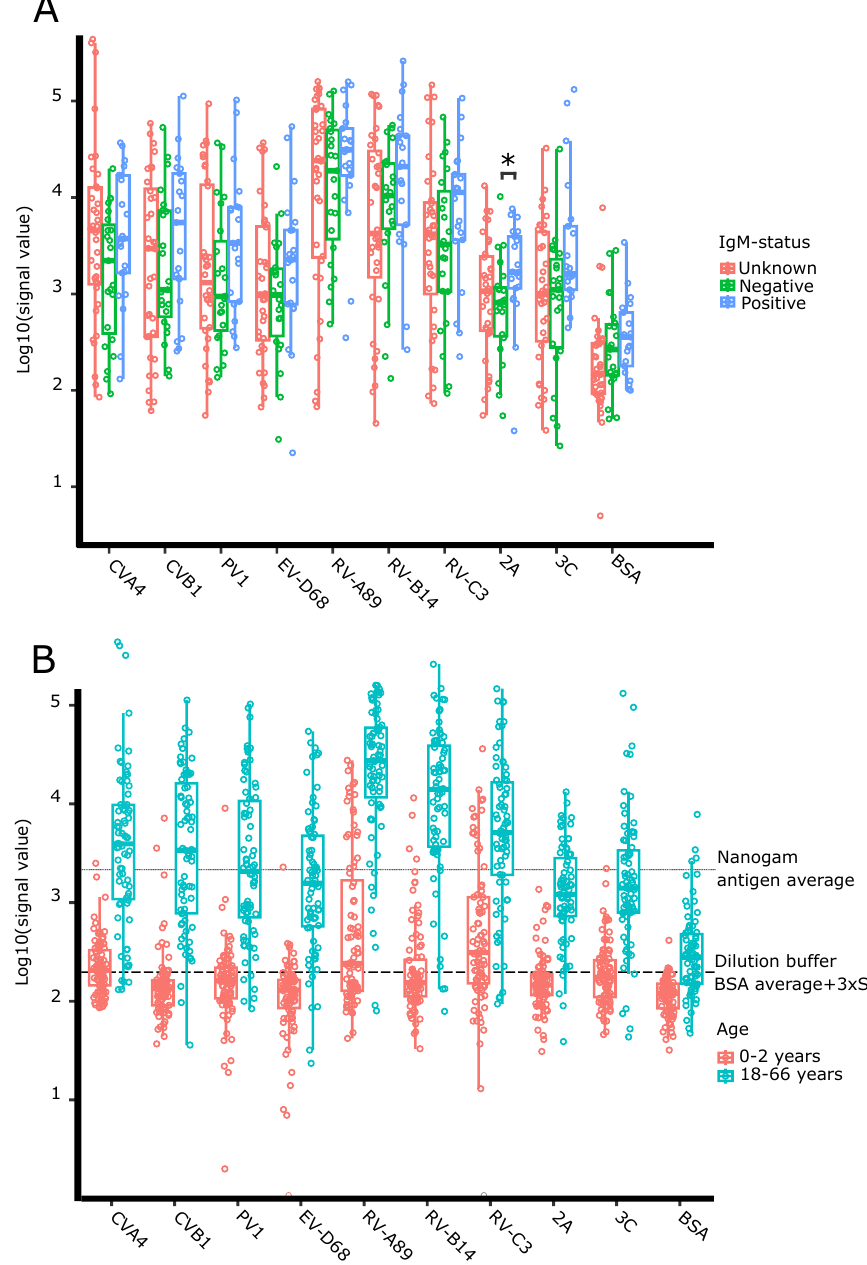
Figure 3. Di ff erent sample groups show variable raw signal ranges in antibody responses for EV and RV antigens in the multiplex assay. ( A ) Adult serum antibody responses grouped by IgM status. ( B ) Antibody responses grouped by the age groups of samples. * p < 0.05 in Wilcoxon rank-sum test after correcting for multiple testing (see Table